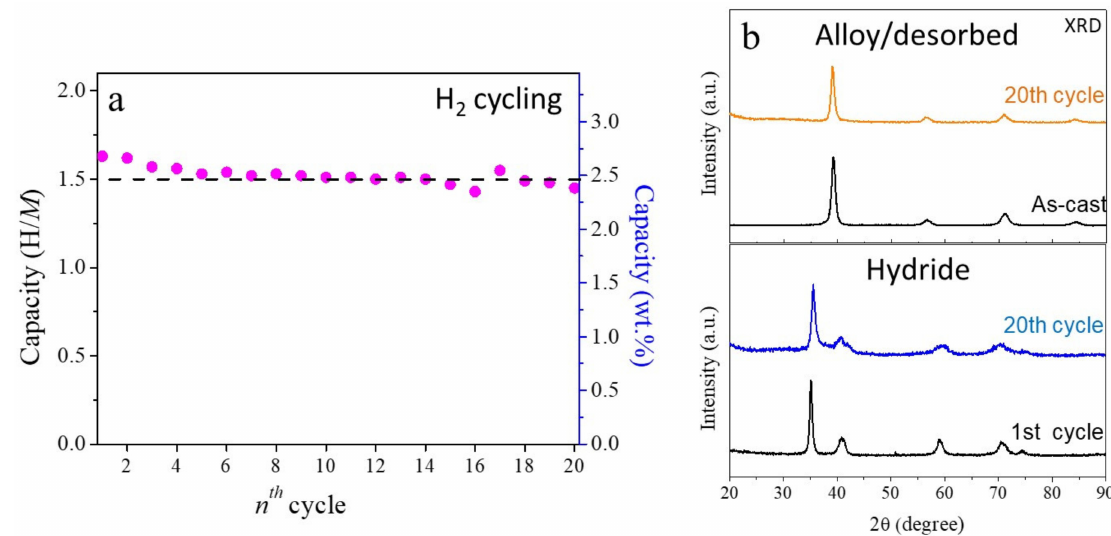
Figure 6. ( a ) Reversible hydrogen absorption capacity of Al 10 Ti 0.30 V 0.25 Zr 0.10 Nb 0.25 upon 20 cycles at 25 ◦ C and ( b ) the XRD patterns before and after 20 cycles as initial and desorbed phases (top) and hydride phases for the 1st and 20th cycles